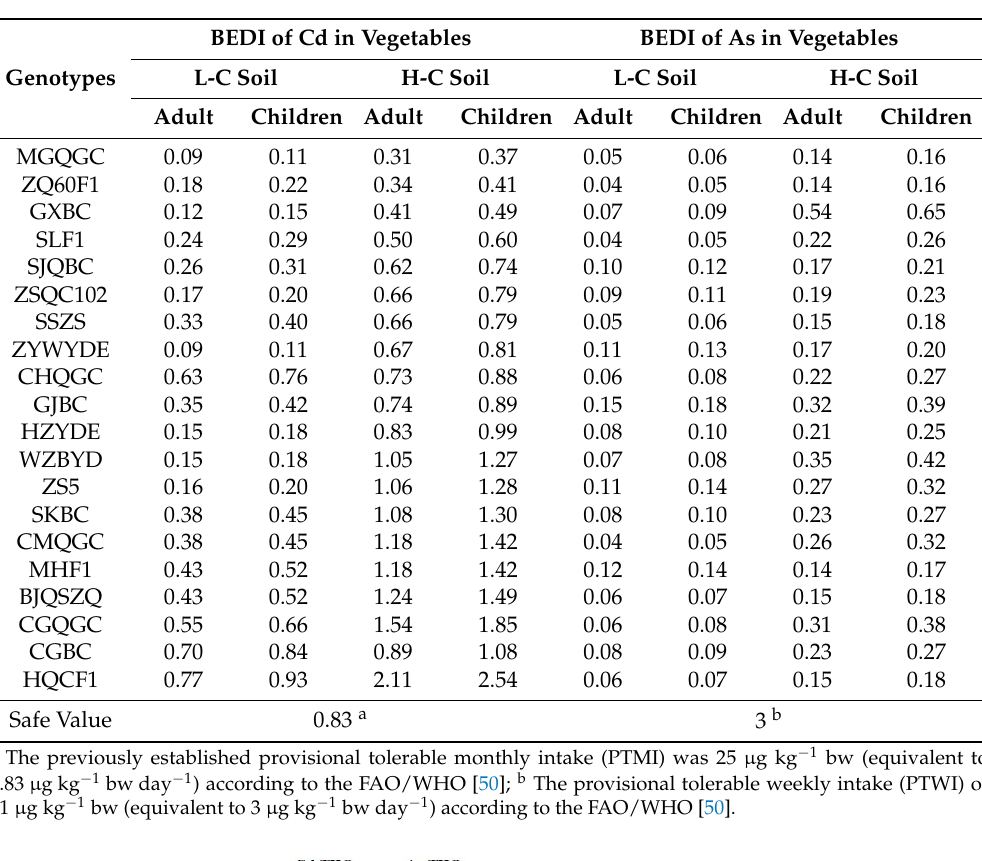
Table 3. The bioaccessible value of estimated daily intake (BEDI) ( µ g kg − 1 bw · day − 1 ) for Cd and As from consumption of pakchoi cultured on low-level co-contaminated soil (L-C soil), and high-level co-contaminated soil (H-C soil).